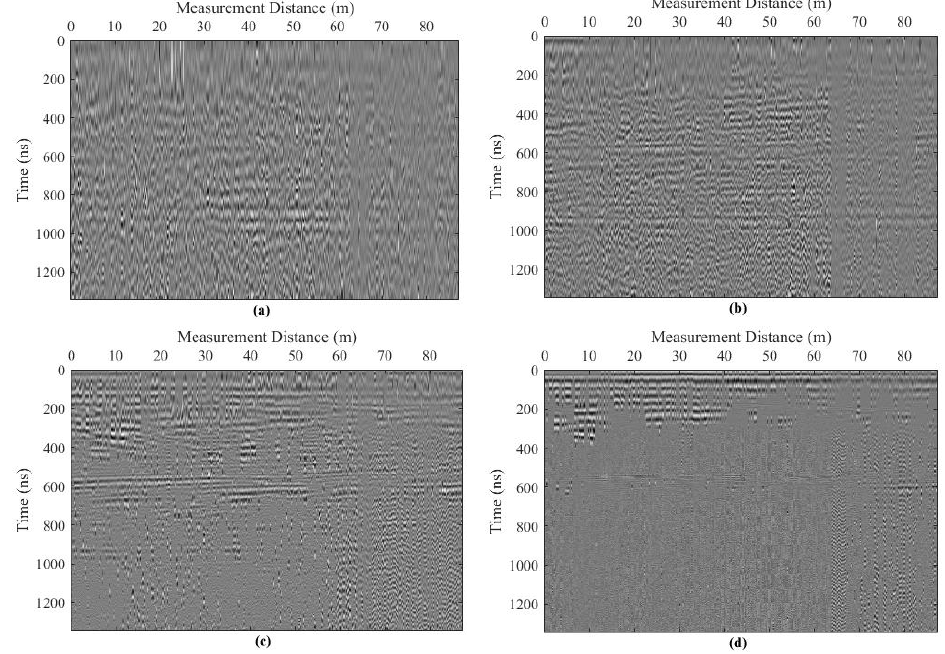
Figure 16. The derived IMF-slices of the field dataset using EMD. ( a – d ) show the IMF-slice 1–4 respectively.